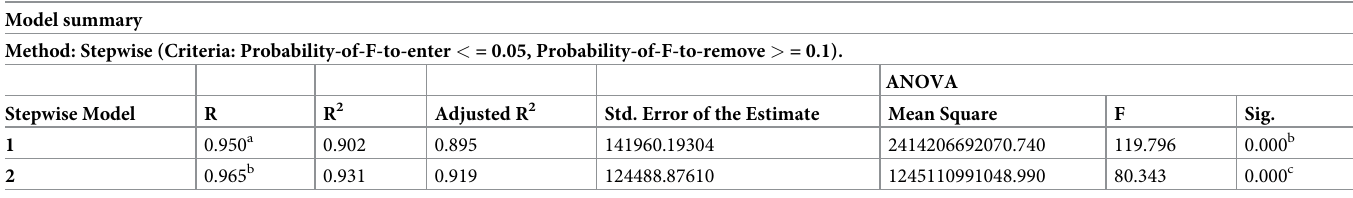
Table 3. Stepwise regression for the relationships between male enrollment, socio-economic factors (general government expenditure, unemployment rate, per cap- ital income, GDP per capita (PPP constant 2011 international $), and GDP at market price) of Pakistan during 2001–02 to 2015–16. Model